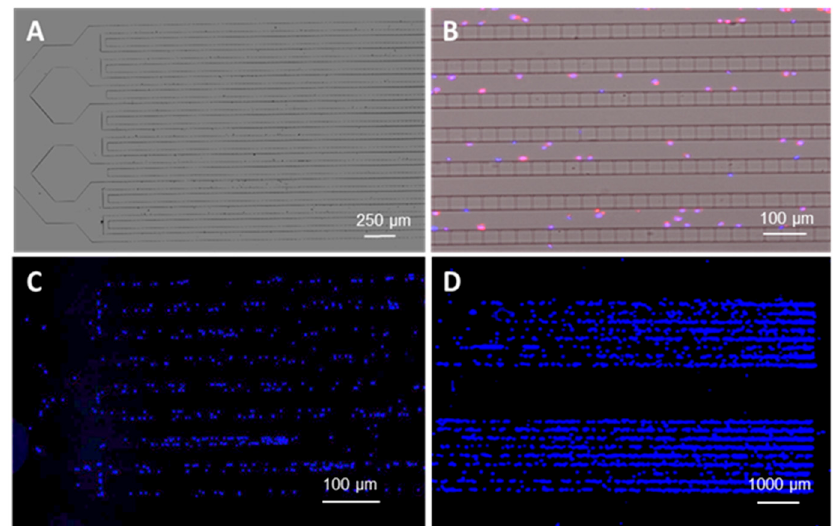
Figure 4. ( A ) Brightfield image of the bifurcated entrance channels of the microtrap device. RPMI-8226 cells were injected into the device at 10 µL/min and contained at the entrance of the microtraps. Cell images were processed according to the procedure listed in the materials and methods section of this manuscript and labeled with DAPI (nuclear stain) and CD38-APC markers. ( B ) Brightfield image merged with DAPI and APC channels showing the presence of the cell nucleus and CD38 on the cell surface aligned mainly at the microtrap entrances. ( C ) Entrance of the single bed device imaged using DAPI. RPMI-8226 cells were trapped inside the device at the entrance to the microtraps. ( D ) Two consecutive beds of the 8-bed device imaged with the DAPI channel of the microscope for stained RPMI-8226